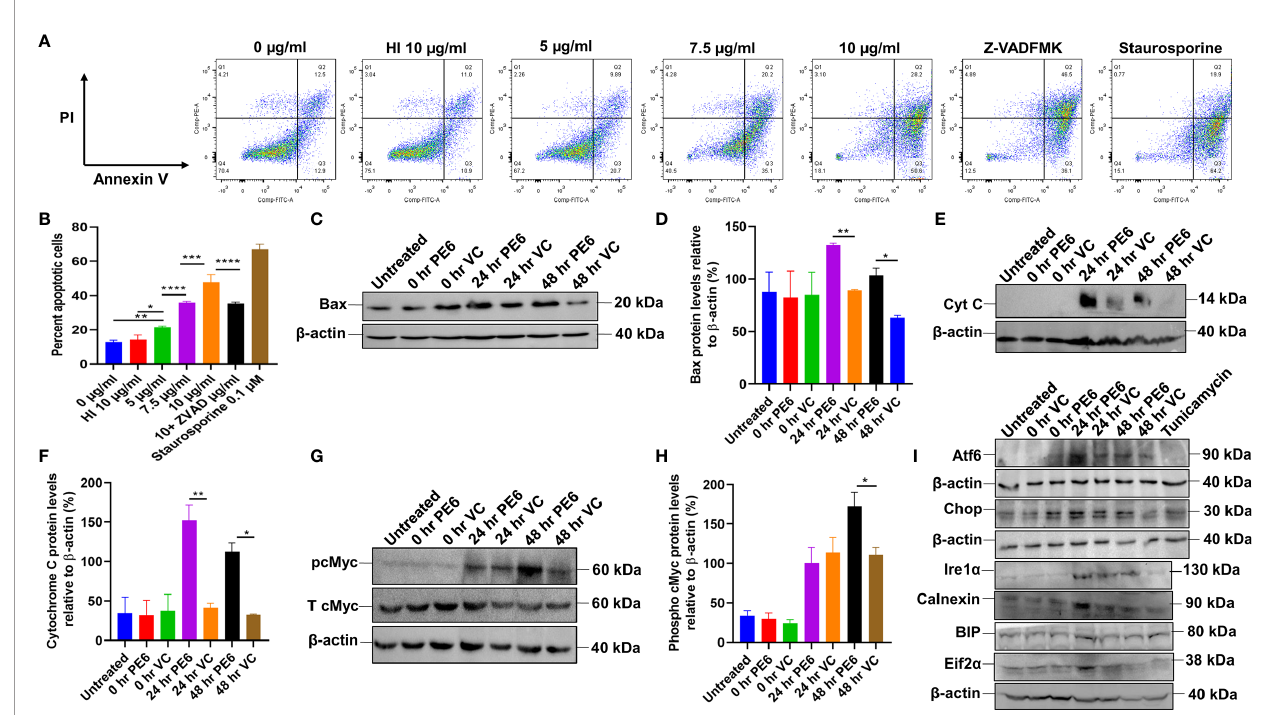
FIGURE 6 | PE6 induced apoptosis activation by inducing pro-apoptotic factors and ef fi ciently activating the ER stress-mediated UPR pathway. (A) Flow cytometric analysis of early apoptotic cells of PE6 treated macrophage cells. Untreated and HI PE6 treated cells were used as negative controls. In contrast, staurosporine and ZVAD-FMK treated cells served as positive and negative controls for caspase-dependent induction and apoptosis repression. Brie fl y, RAW264.7 cells were seeded in a 6-well tissue culture plate, after 2 h of adherence at 37°C, the cells were treated with PE6 (5, 7.5, and 10 µ/ml), HI PE6 (10 µg/ml), 0.1 µM staurosporine, and 20 µM pan-caspase inhibitor Z-VAD-FMK. After completing the treatment, cells were harvested and processed as instructed by the manufacturer (BD Biosciences, San Jose, USA). Sample ’ s reading was captured using the BD FACSVerse machine. Images were analyzed using FlowJo software. (B) Graphical representation of apoptosis induction by treatment of various concentrations of PE6. (C) Western blot analysis of recombinant M. smegmatis infected macrophage cells after 24 and 48 h of infection. Western blot was performed using an anti-Bax antibody. (D) Densitometric analysis of Bax protein levels normalized to b -actin. (E) Western blot showing the levels of Cytochrome C protein in macrophage cells infected with recombinant M. smegmatis . (F) Densitometric quantitation of Cytochrome C protein levels relative to b -actin represented as a bar graph. (G) Western blot analysis of pcMYC levels in recombinant M. smegmatis infected macrophage cells. (H) Densitometric quantitation of pcMYC levels relative to b -actin and represented as a bar graph. Untreated and vector alone transformed cells were used as negative controls. Protein levels were represented as [%] to b -actin and total cMYC. Data were analyzed by one-way ANOVA with Tukey ’ s multiple comparison post- test. Data are representative of three independent experiments. *P < 0.05, **P < 0.01, ***P < 0.001, ****P < 0.0001 vs . controls. (I) Western blot analysis showing the levels of UPR markers in recombinant M. smegmatis infected macrophage cells. RAW264.7 macrophage cells were infected with recombinant M. smegmatis at MOI of 1:10 for 24 and 48 h. The cell lysate was prepared, run in SDS-PAGE, transferred onto the PVDF membrane, and Western blotted using anti-Atf6, anti-Chop, Ire1 a , Calnexin, BIP, and Eif2 a antibodies. Untreated and vector alone transformed cells were used as controls. b -actin was used as a loading